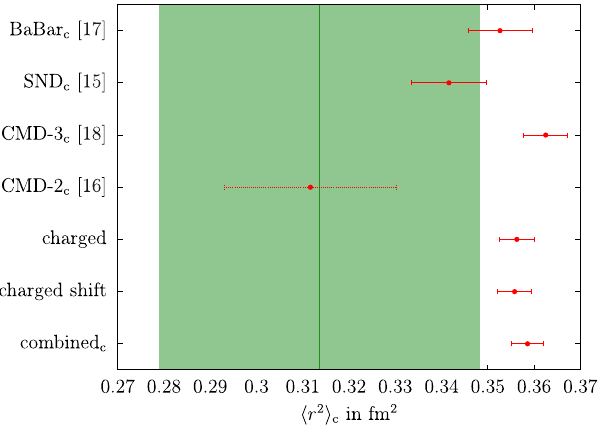
Fig. 7 Results of the individual and the combined charged (left) and neutral (right) data sets of the squared mean charge radius for the charged (left) and neutral (right) kaon, for all fit variants in the same